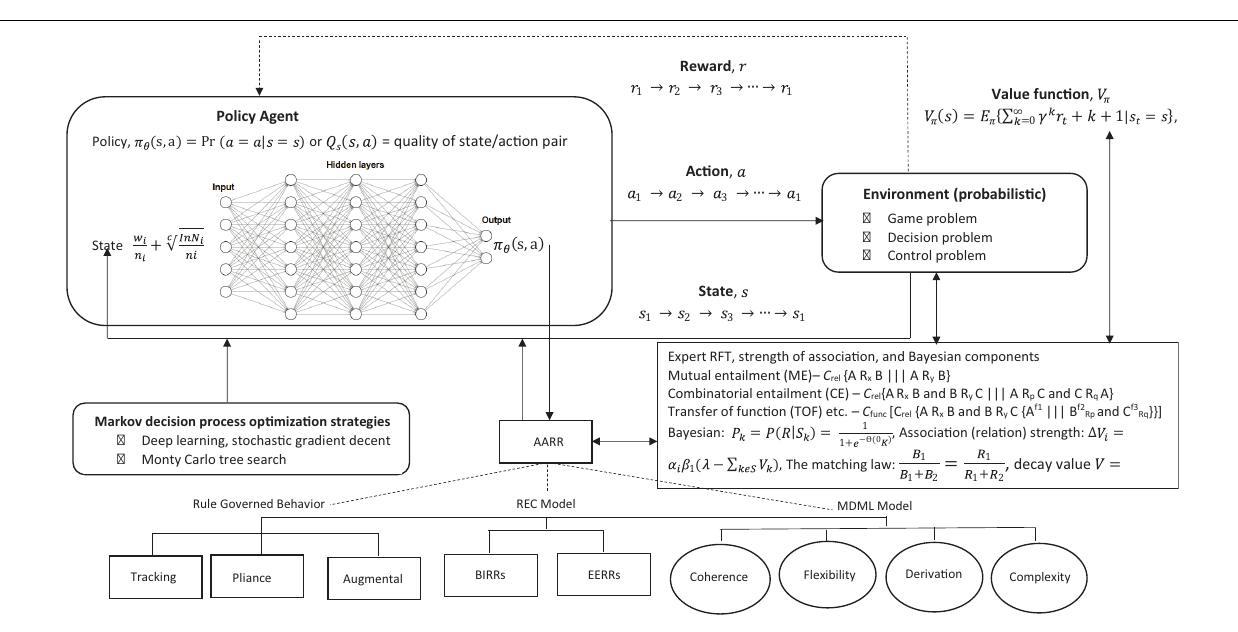
FIGURE 9 | The REC RFT adapted version of the RL machine learning framework, with a deep neural network implemented as policy optimizer.